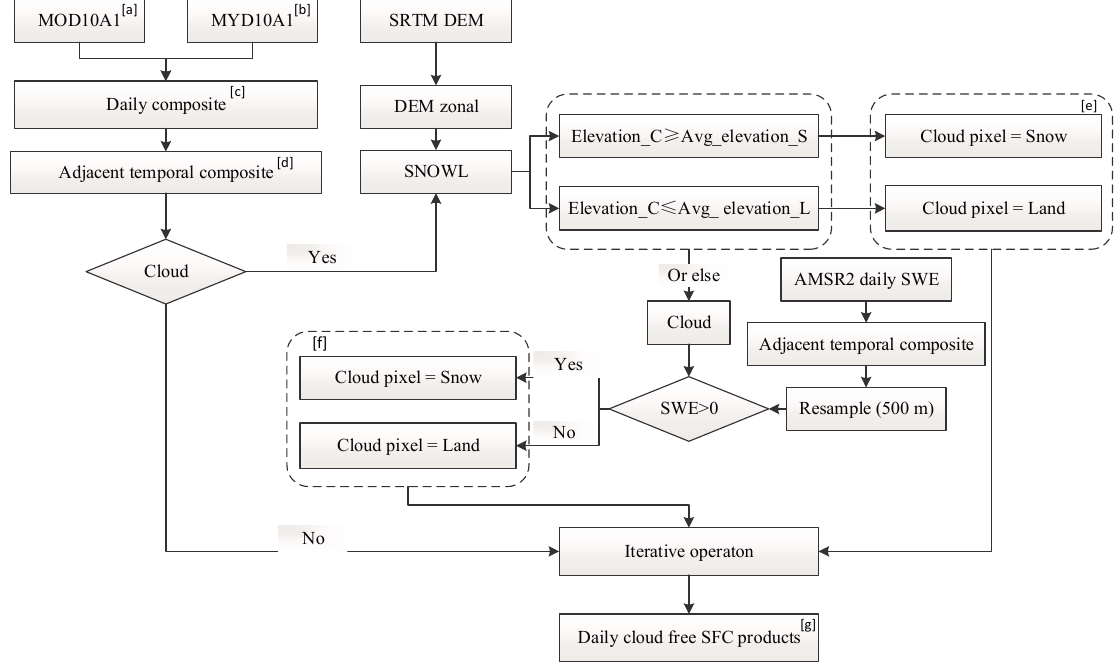
Figure 3. Flow chart for the daily cloud-free MODIS FSC product (The label from a –